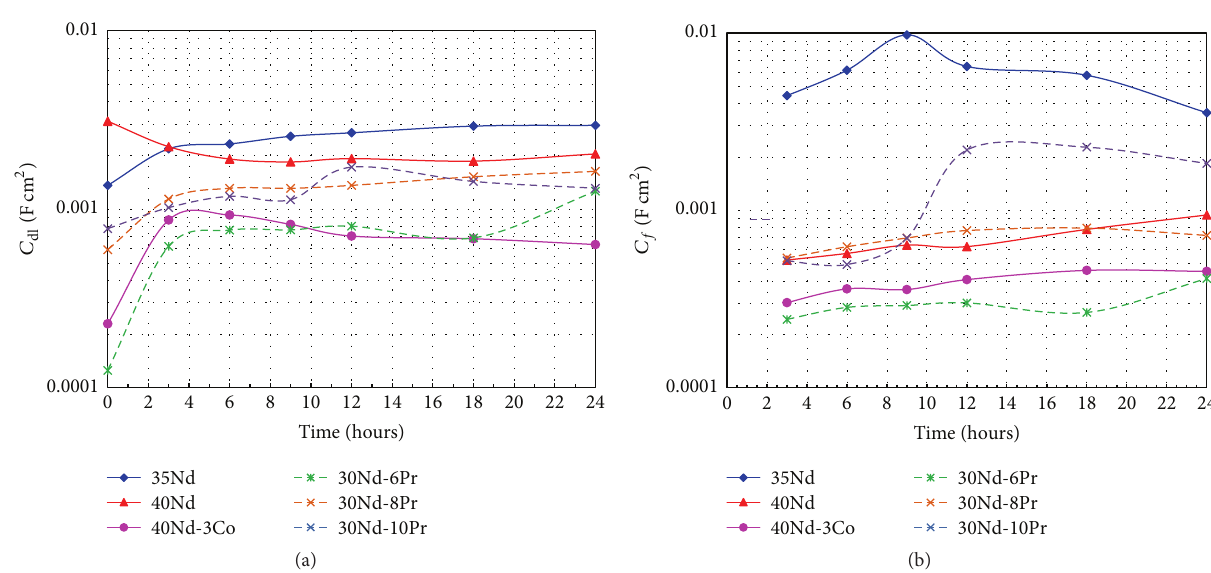
Figure 21: 𝐶 dl and 𝐶 𝑓 variation against time for the tested